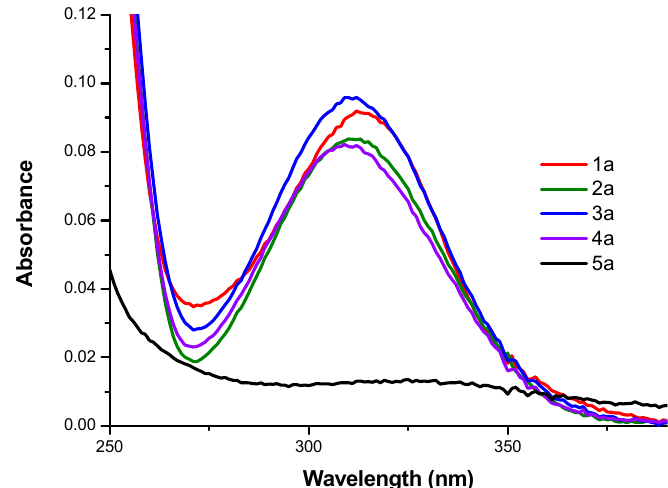
Figure 3. Absorbance spectra of N -alkyl-bis- o -aminobenzamides 1a – 5a [1 × 10 − 5 M] in water at pH = 5.4.